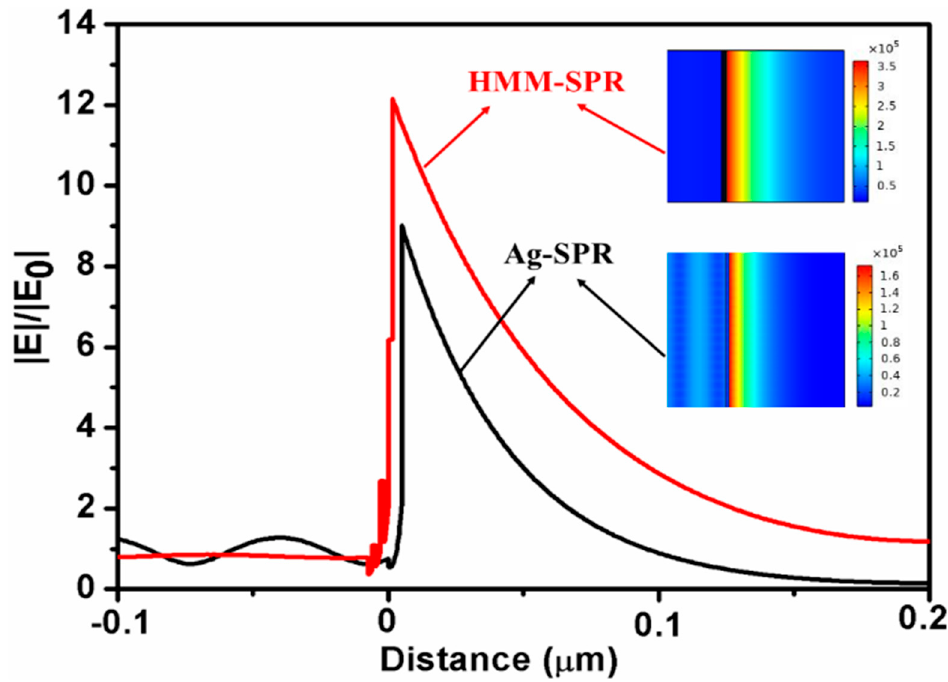
Figure 4. The distribution of normalized optical electric field |E|/|E 0 | along with the device distance.